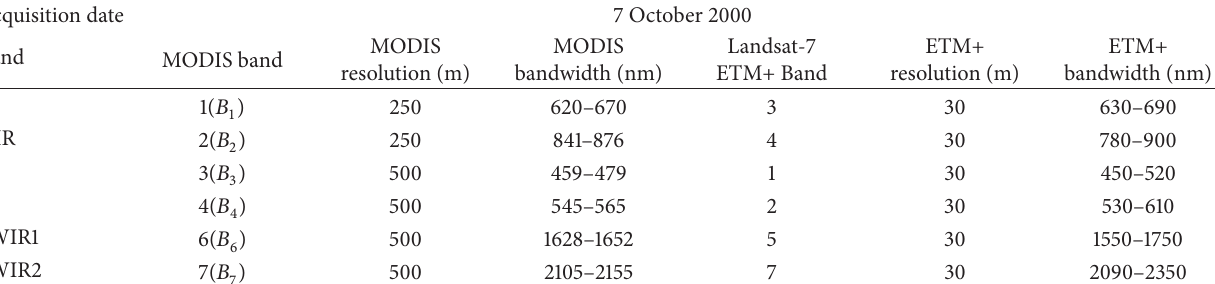
Table 1: Bands information comparison of MODIS a and Landsat-7 ETM+ b